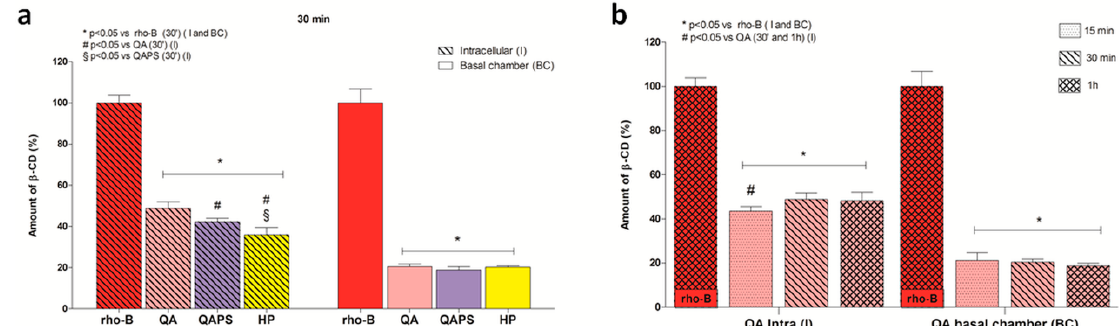
Figure 5. Evaluation of transepithelial permeability of RBITC-HP, RBITC-QA and RBITC-QAPS (5 µM) in CACO-2 cell monolayers. ( a ) Amount of cyclodextrins accumulated into the cells and in the basolateral compartment at 30 min. * p < 0.05 vs rho-B - I and BC; # p < 0.05 vs. RBITC-QA - I; § p < 0.05 vs. RBITC-QAPS - I (ANOVA test). ( b ) Amount of RBITC-QA accumulated into the cells and in the basolateral compartment at 15, 30 and 60 min. * p < 0.05 vs. rho-B - I and BC; # p < 0.05 vs. 30 min - I and 60 min - I (ANOVA test). Data are reported as mean ± SD ( n = 3).